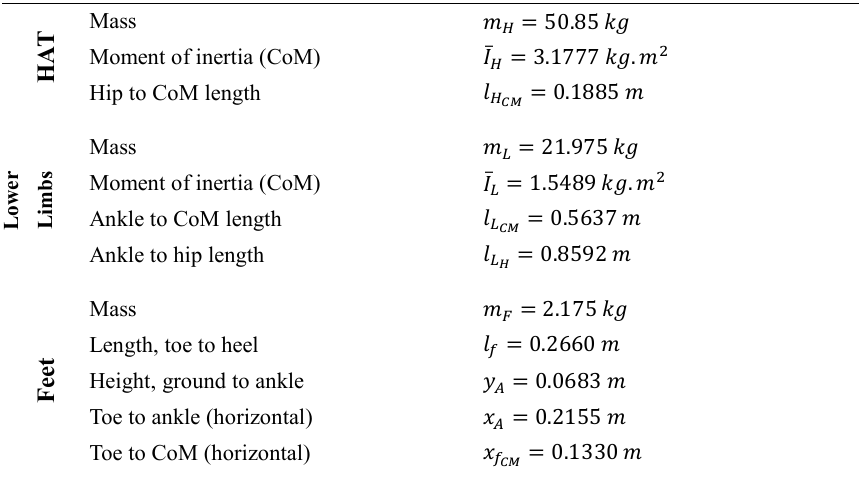
Table 2. Anatomical parameters used for the 3-link model shown in Figure 3.